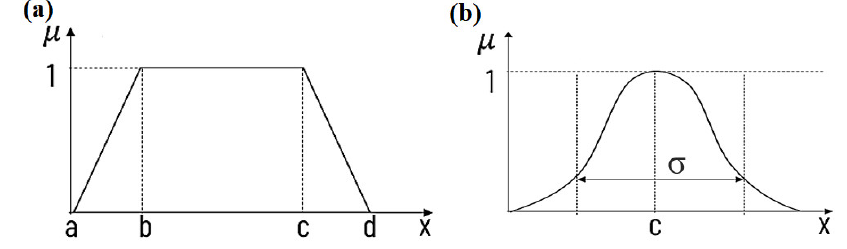
Figure 3. Membership functions: ( a ) Trapezoidal; ( b ) Gaussian.